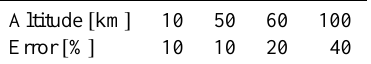
Table 4. Number of collocations for OZORAM comparison with the satellite instruments MLS and SABER. Both datasets, OZORAM-HITRAN and OZORAM-JPL, yield the same number of collocations.